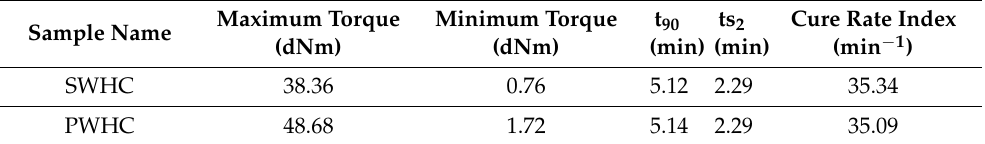
Table 2. Torque and cure time values of the SWHC and PWHC